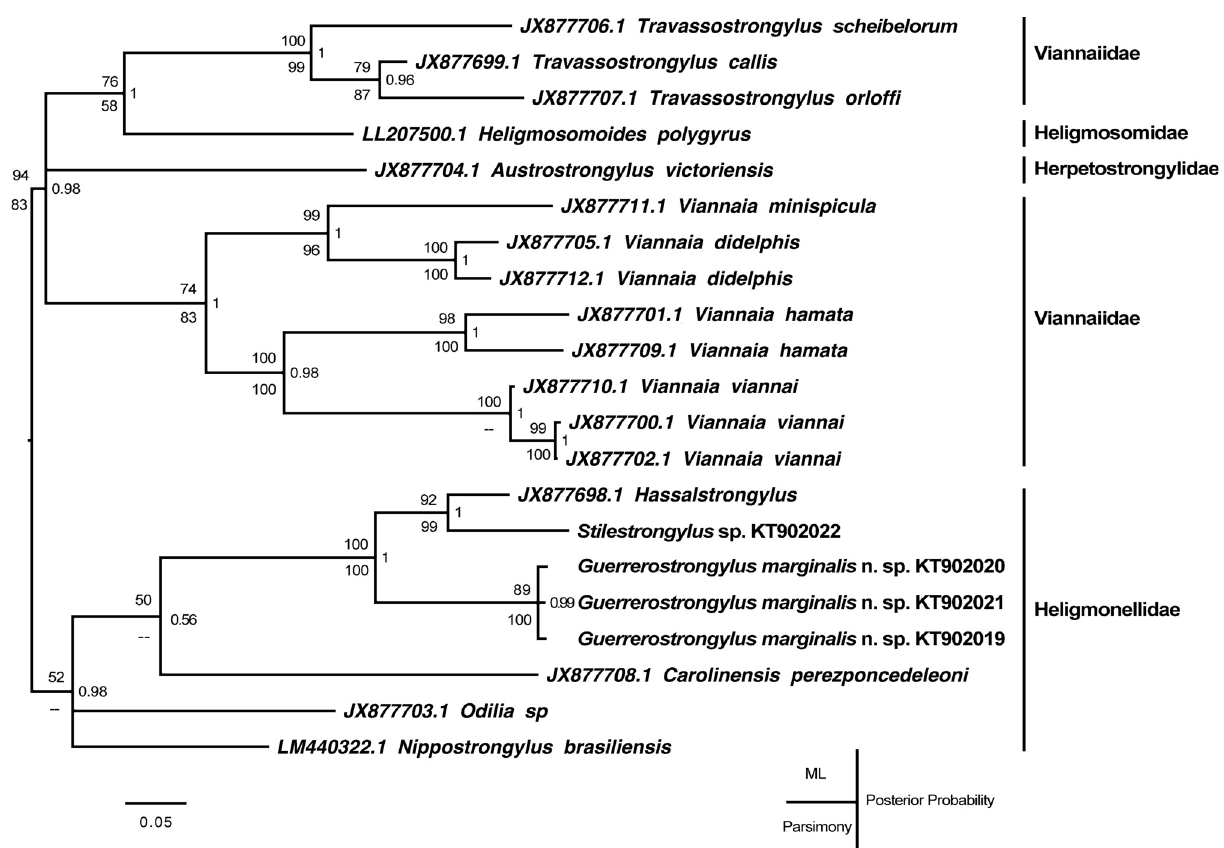
Figure 13. Placement of Guerrerostrongylus marginalis n. sp., relative to available heligmonellid nematodes. The phylogenetic tree (based on a fragment of the mitochondrial gene coding for the large ribosomal subunit RNA – rrnL -) represents the consensus used to calculate the posterior probability of the branches. Posterior probability is to the right of each node. Bootstrap support values are indicated to the left of the node, with values for Maximum Likelihood support over those obtained by